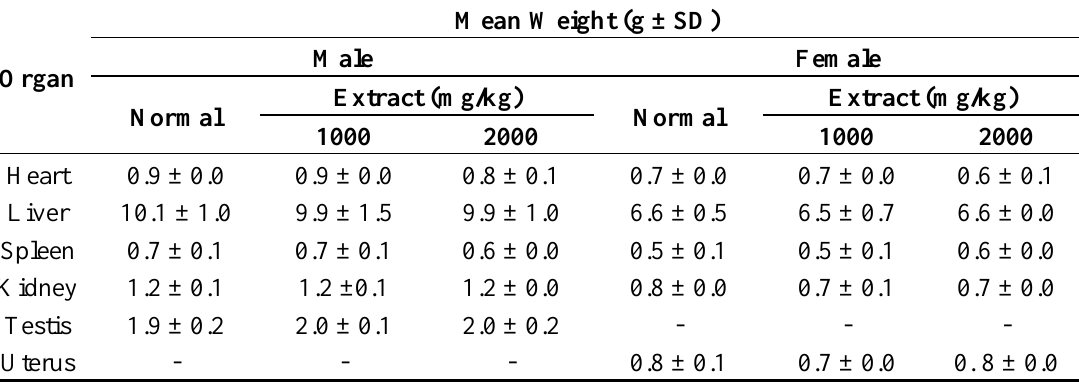
Table 2. Mean organ weight of rats after 28 days treatment with A. sinensis extract.